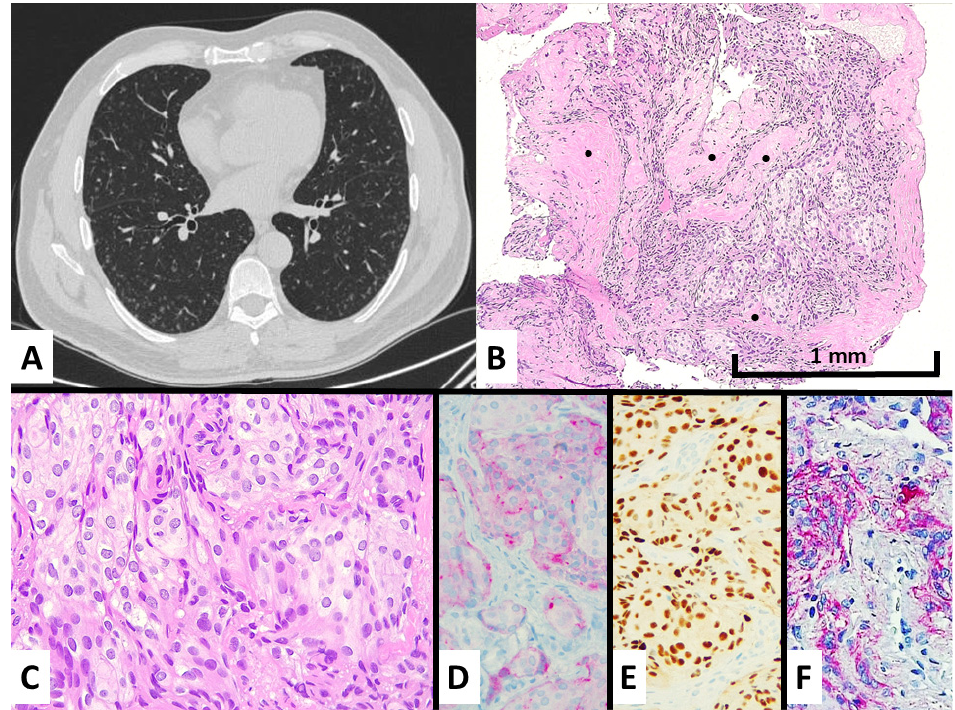
Figure 1. Case #1 manifested with an incidental discovery of diffuse bilateral micronodules also showing ground glass appearance and central cavitation at chest CT scan ( A ) and spindled-to-epi- thelioid cell proliferation with intermingled fibrosis (see black dots) at transbronchial biopsy ( B ), hematoxylin–eosin magnification × 100, consisting of bland-looking cells with moderate cytoplasm lacking mitotic figures ( C ), hematoxylin–eosin stain magnification × 200. These cells showed a me- ningothelial cell differentiation by expressing EMA at cytoplasmic level ( D ), immunohistochemistry magnification × 200, progesterone receptors in the nuclei ( E ), immunohistochemistry magnification × 200, CD56 in cytoplasm and membrane ( F ), and immunohistochemistry magnification × 200. Immunohistochemically, the lesions showed consistent expression of epithelial mem- brane antigen (EMA), progesterone receptor, and CD56, whereas neuroendocrine, smooth